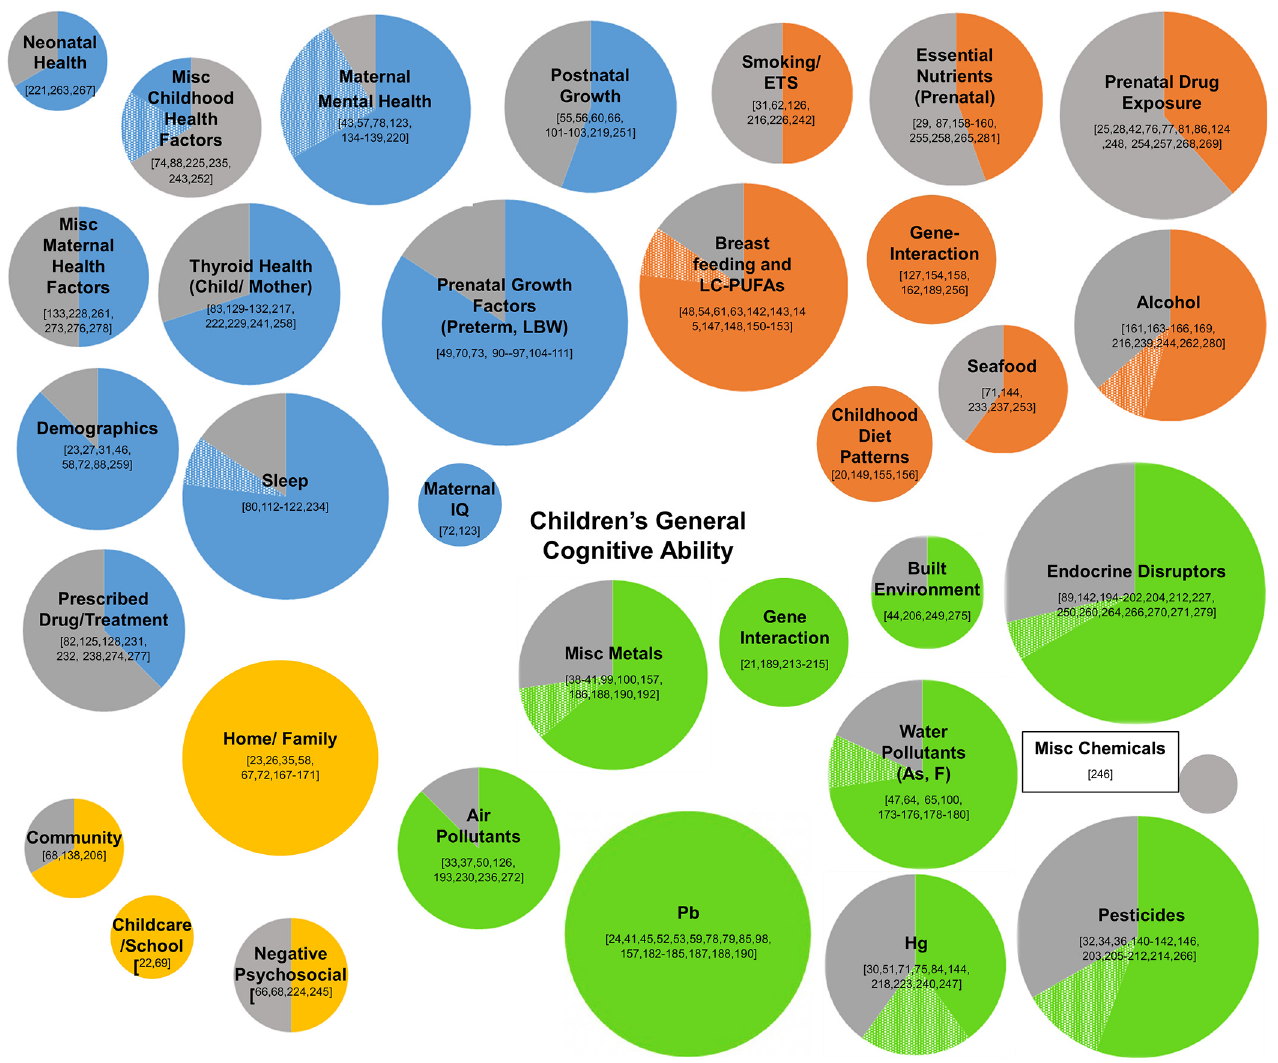
Fig 3. Factors Associated With General Cognitive Ability Further Divided Into Sub-categories. The color of the circles corresponds to the larger categories in which these sub-categories are grouped (inherent: blue; behavioral: orange; social environment: yellow and physical environment: green). The size of the circles is in proportion to the total number of publications included in the review (n = 258). The colored section in each circle represents the proportion of publications within each category that found a statistically significant association with general cognitive score (solid color – P < 0.05; pattern – 0.05 < P < 0.10). This graphic is adapted from Strina et al.